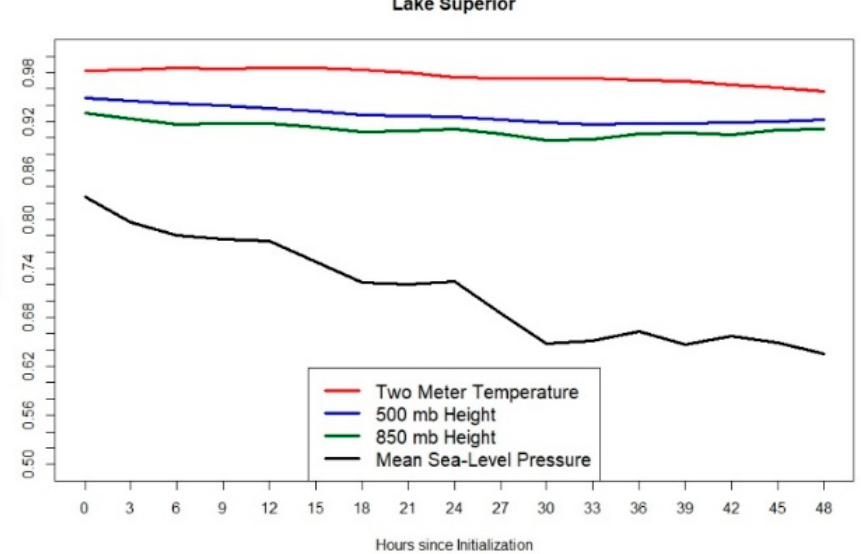
Figure 12. Average Pearson correlation coefficients between each listed spatial field for all three Lake Superior clusters.